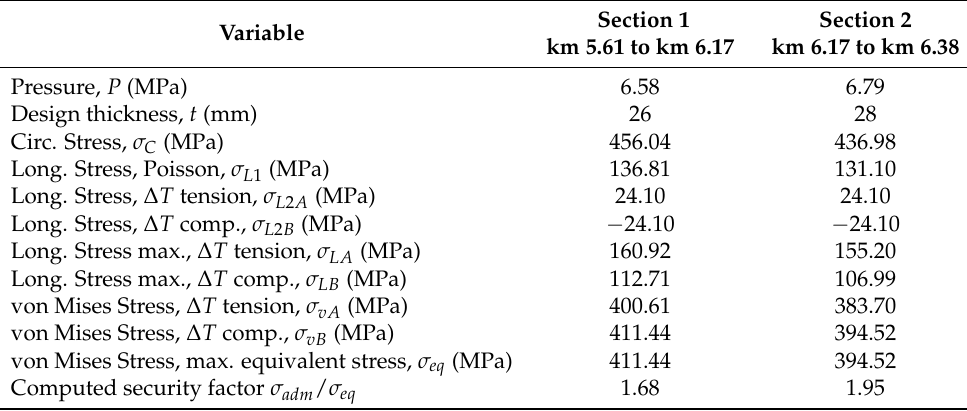
Table 2. Structural calculations for internal pressure loads